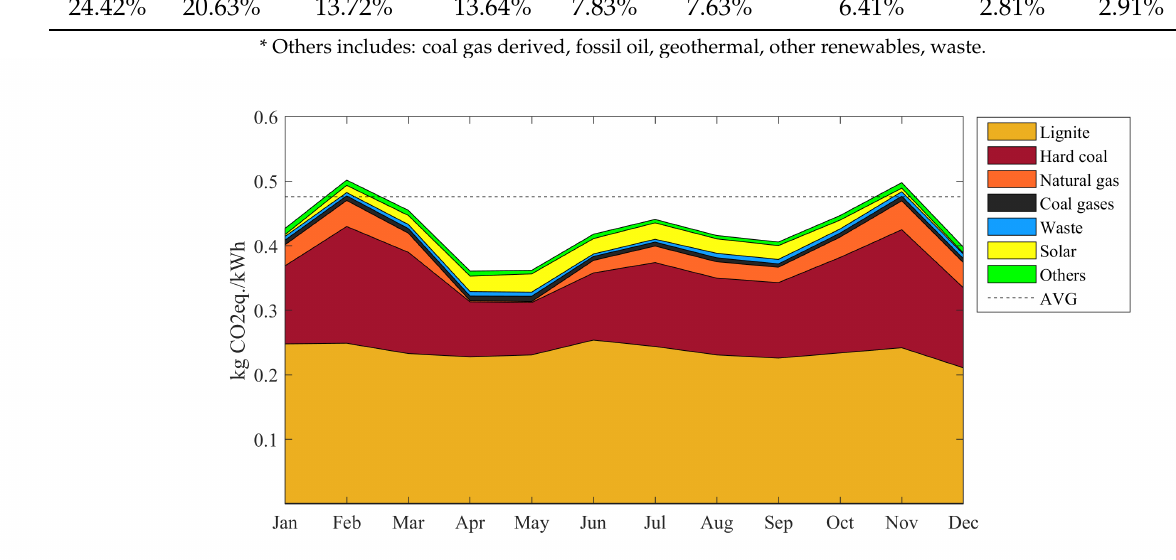
Figure 5. Monthly peak hours GWP compared with average through the year (dotted line) in Germany.